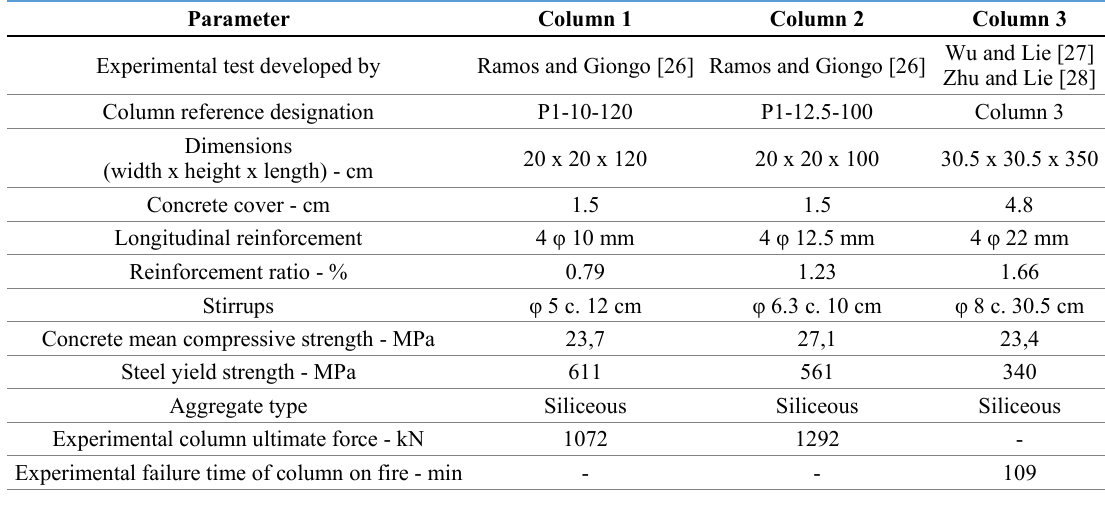
Table 1 S tudied columns